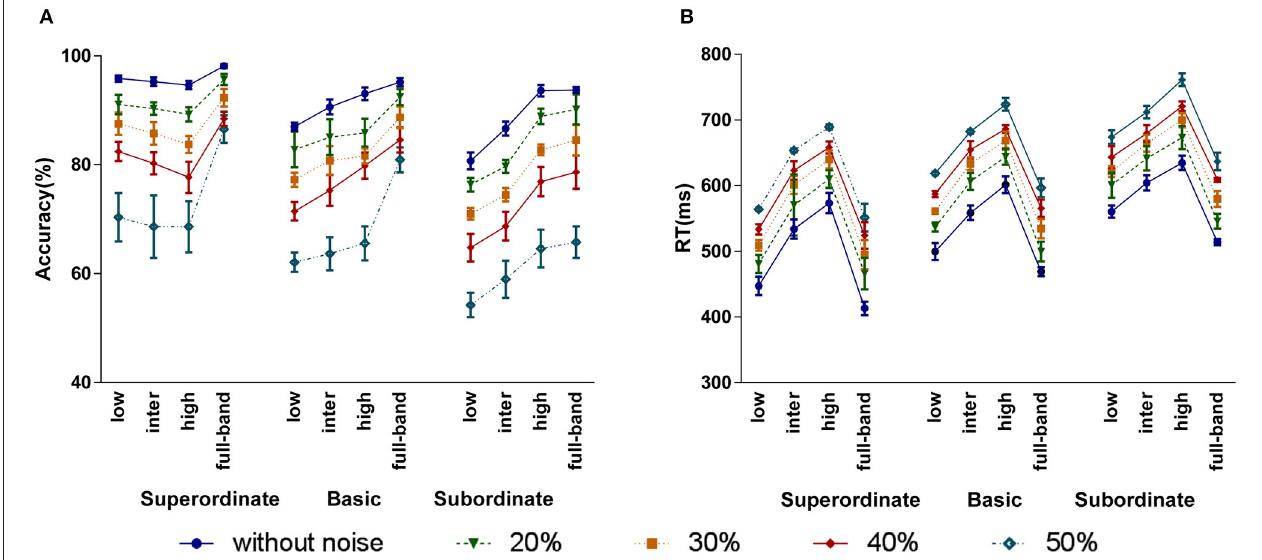
FIGURE 8 | The effect of adding different amounts of noise to the image stimuli (20, 30, 40, and 50%) on humans’ accuracy (A) and RT (B) . Error bars represent standard error of the mean (SEM). The between (within) group df is 59 (540).